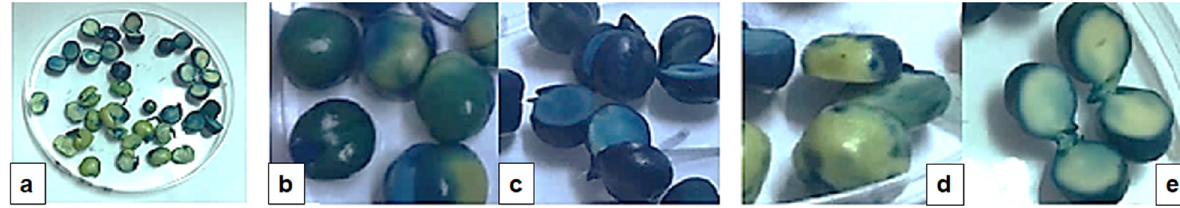
Figure 3. Visualization of Nelyubov method used for determining the viability of peas ( b , d ) and chickpeas ( c , e ): ( a ) the control (distilled water); ( b , c ) the first washing; ( d , e ) the second washing. The incubation time was 90 min.